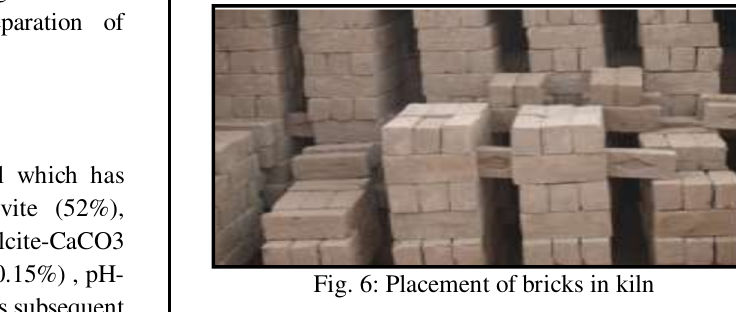
Fig. 6: Placement of bricks in kiln